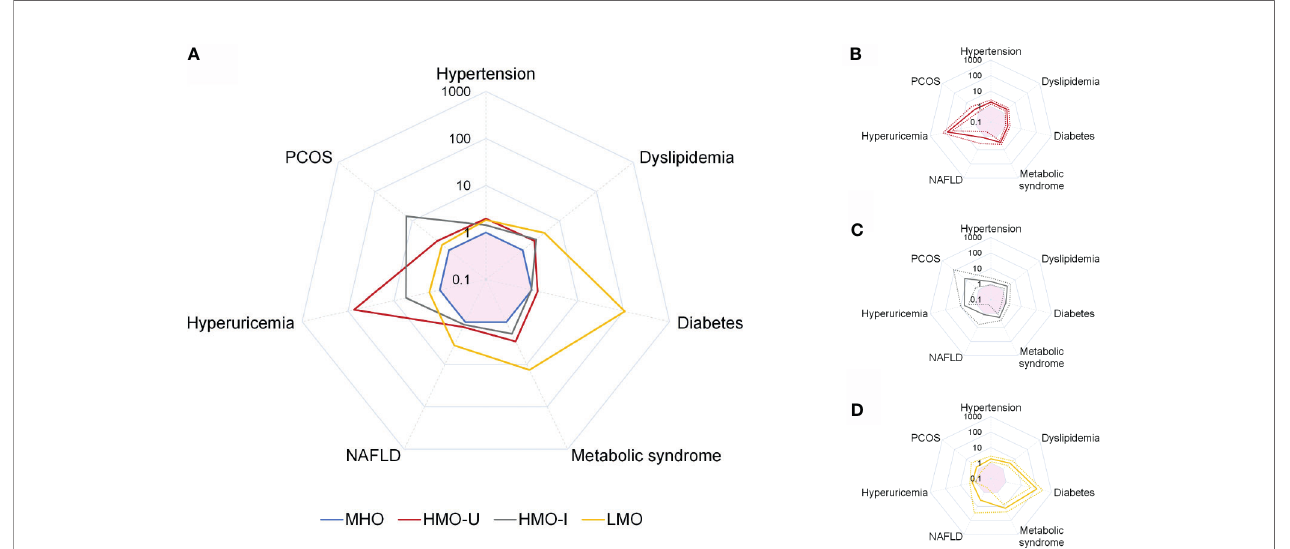
FIGURE 4 | Comparison of adjusted odds ratio (AOR) for obesity comorbidities across the four clusters generated from Cohort-1 using k-means. Comparison of AOR across the four clusters (A) , and AOR and 95%CI for HMO-U (B) , HMO-I (C) , and LMO (D) . MHO is used as the reference category. Analyses are adjusted for sex and age. Values are shown as AOR (solid line) and/or 95%CI (dash line). Pink shadow in the center of each spider diagram is area for AOR < 1. HMO-I, hypermetabolic obesity hyperinsulinemia subtype; HMO-U, hypermetabolic obesity hyperuricemia subtype; LMO, hypometabolic obesity; MHO, metabolic healthy obesity; NAFLD, nonalcoholic fatty liver disease; PCOS, polycystic ovary